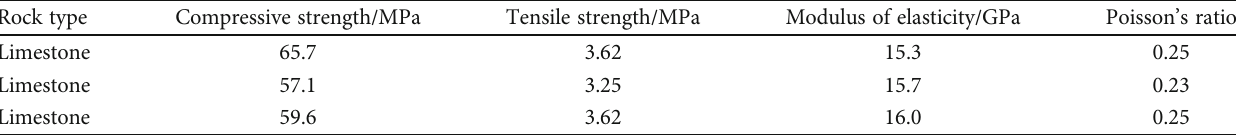
Table 1: Mechanical parameters of